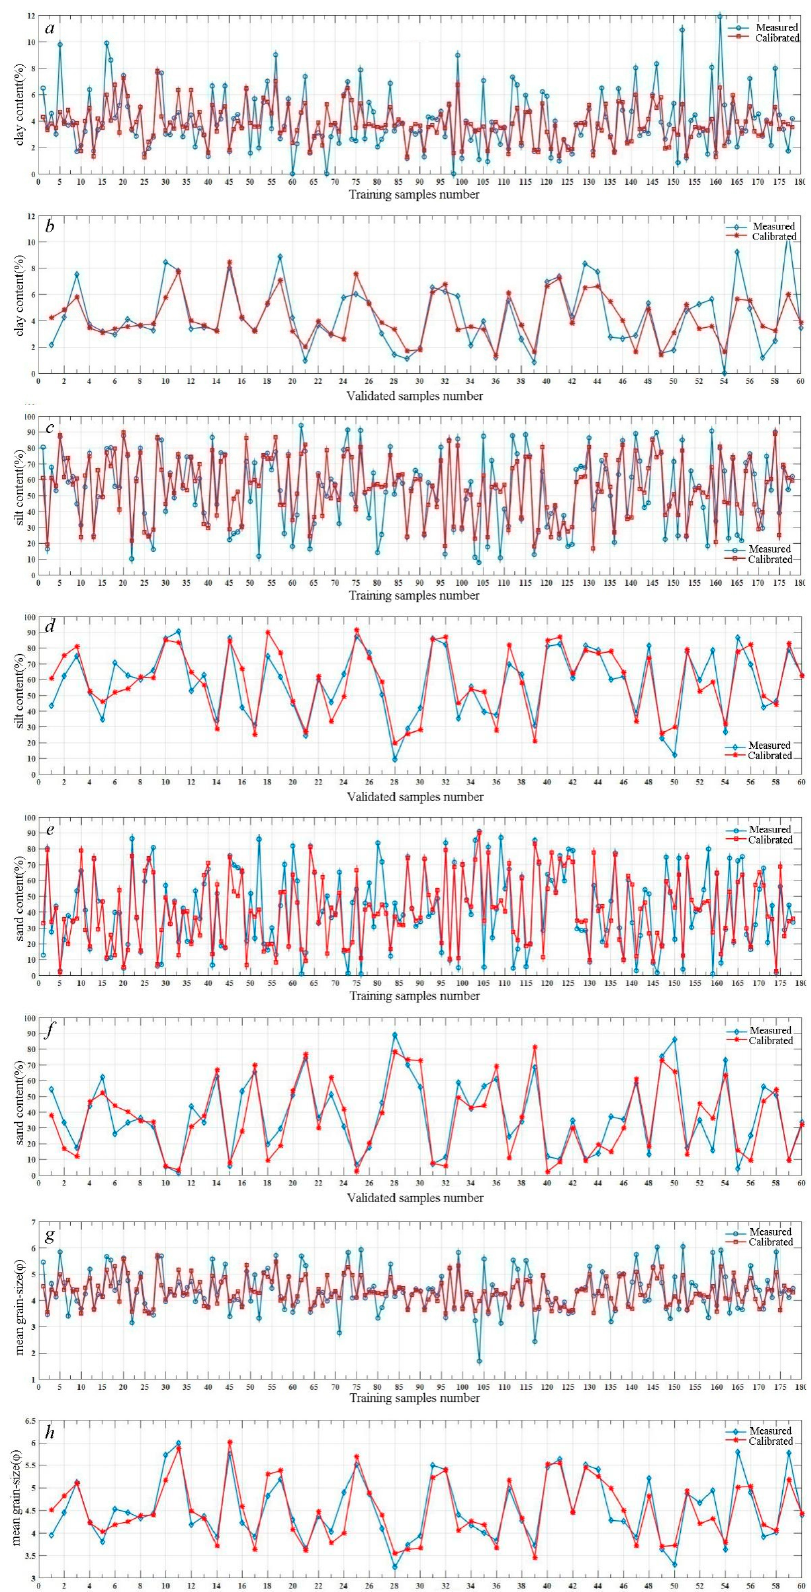
Figure 6. Optimal parameters of SVM model for clay ( a ), silt ( b ), sand ( c ), and mean grain-size ( d ).